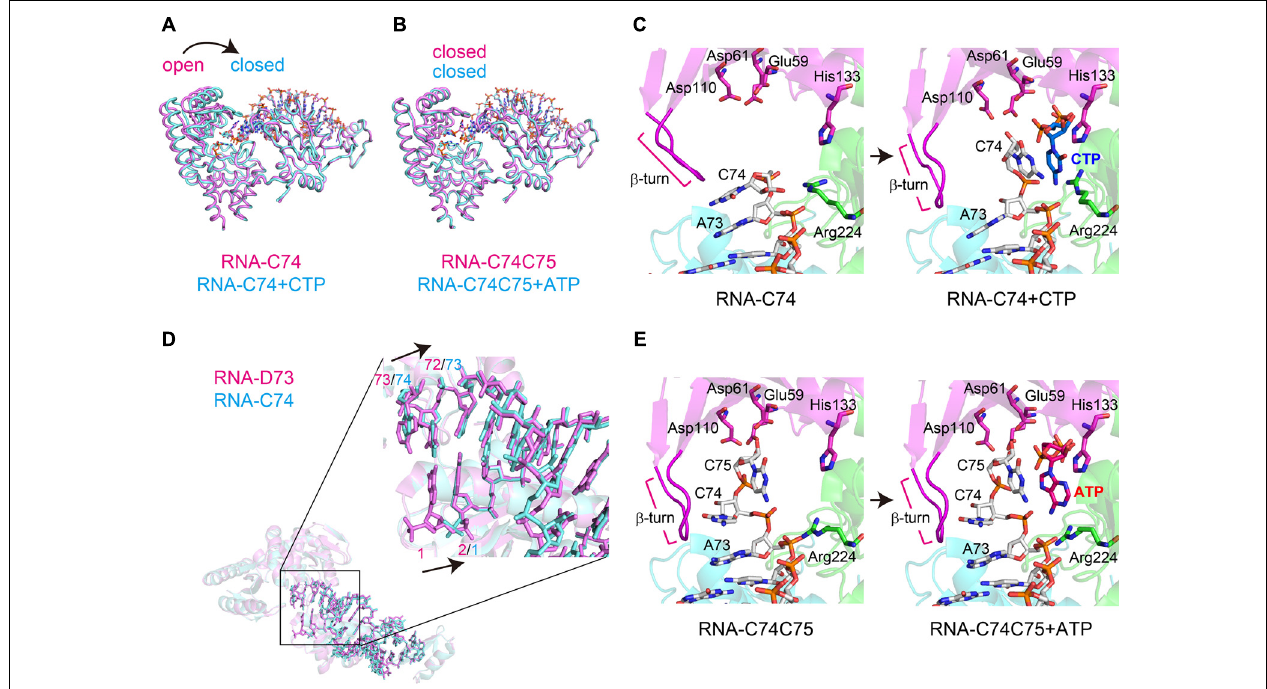
FIGURE 3 | Dynamics of CCA-addition by the class-I CCA-adding enzyme. (A) Superimposition of the complex structures of AFCCA with a tRNA mini-helix at the C 75 -adding stage, in either the absence (colored magenta) or the presence (colored cyan) of CTP. (B) Superimposition of the complex structures of AFCCA with a tRNA mini-helix at the A 76 -adding stage, in either the absence (colored magenta) or the presence (colored cyan) of ATP. (C) Comparison of the catalytic core structures of AFCCA at the C 75 -adding stages in either the absence (left) or the presence (right)